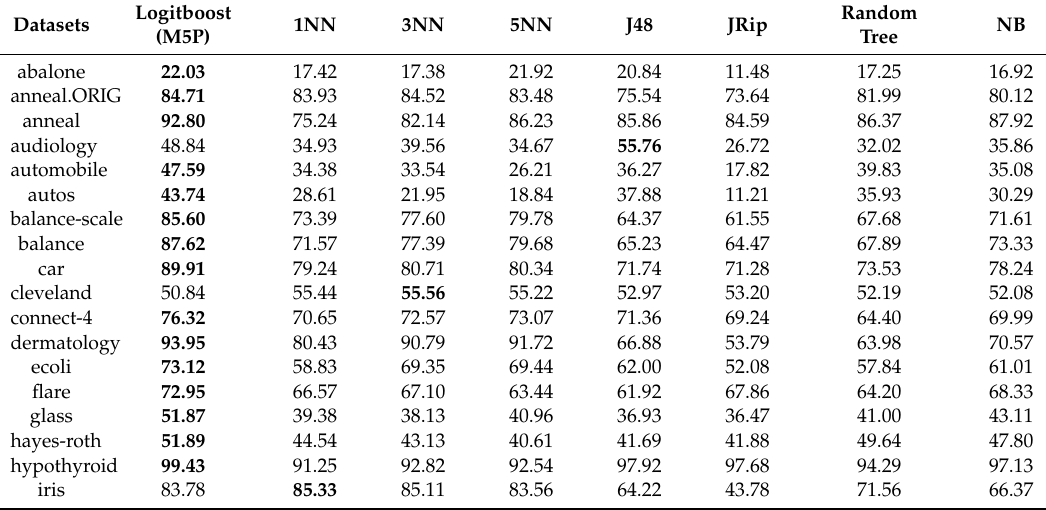
Table 4. Classification accuracy of the Logitboost(M5P) against the selected simple base learners for multi-class datasets under UncS(Ent) strategy with R =